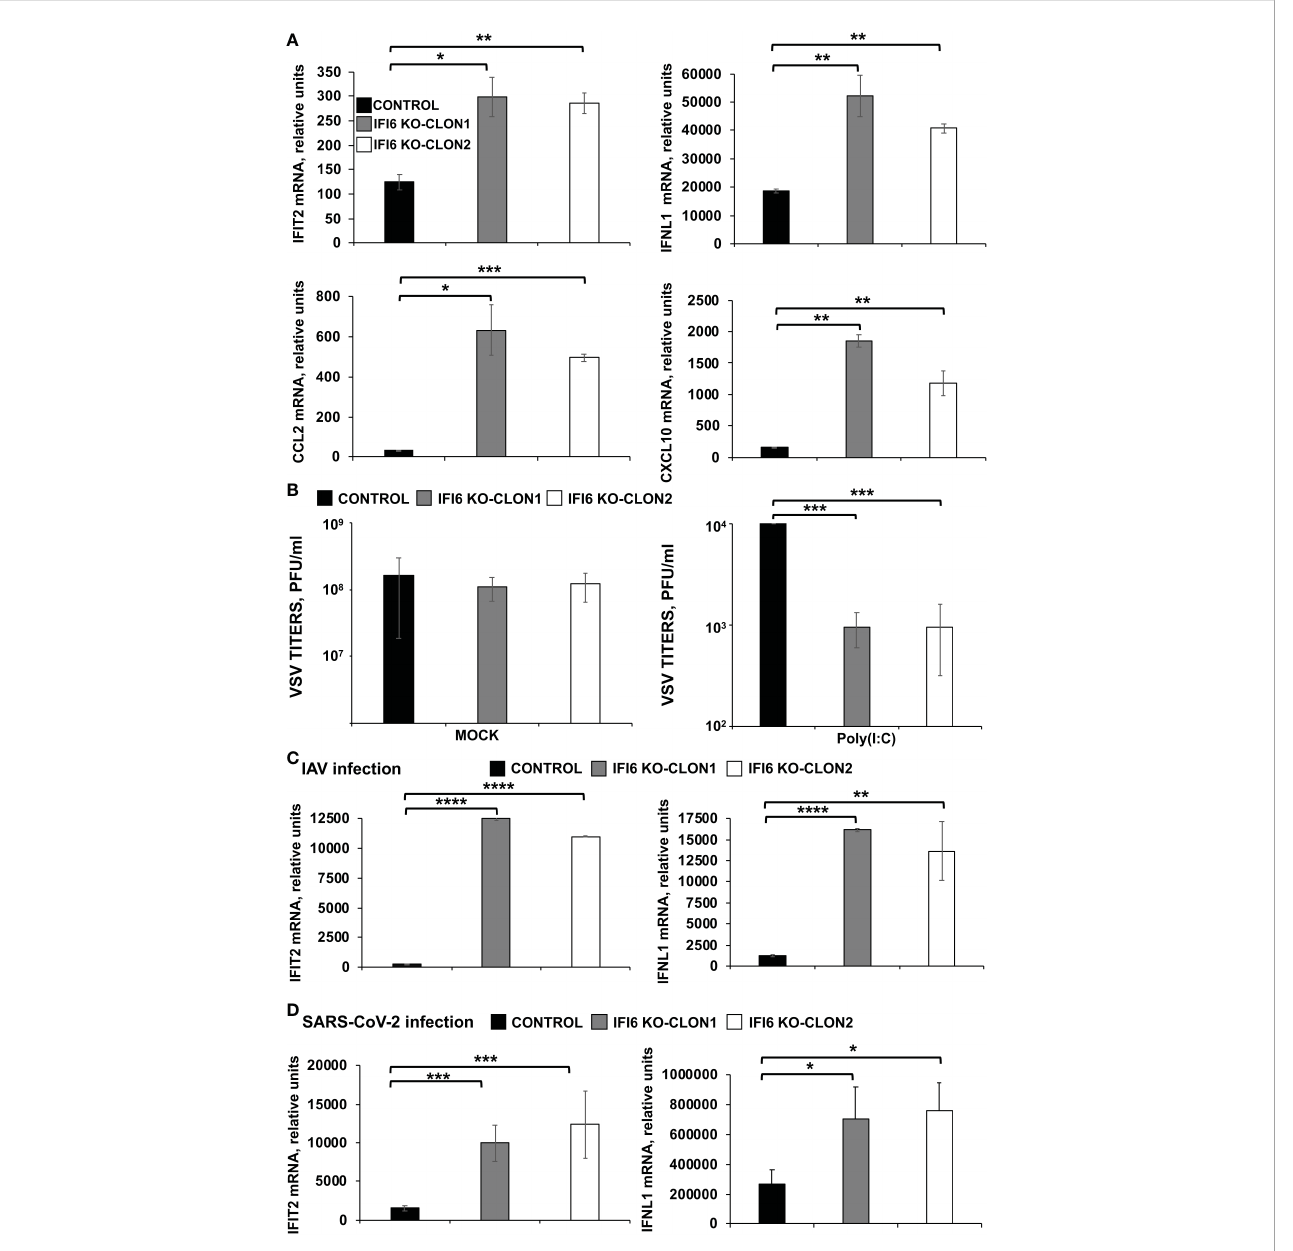
FIGURE 5 Effect of IFI6 on the modulation of innate immune responses induced by poly(I:C) and viral infections in A549 epithelial cells. (A, B) Two clones of A549 cells speci fi cally KO for the gene IFI6 were treated with poly(I:C). (A) To analyze the effect of IFI6 on innate immune responses, the levels of IFIT2, IFNL1, CCL2, and CXCL10 were evaluated by RT-qPCR at 24 hpt, and mRNA levels were expressed as fold change (increases) in comparison to mock-treated cells, used as controls. (B) Cells that had been subjected to mock treatment, or transfected with poly(I:C), were infected with rVSV-GFP (MOI of 0.1), and viral titers at 24 hpi were measured by a lysis plaque assay. Three different experiments were performed, with similar results. *P<0.05, **P<0.01, ***P<0.001 (using Student ’ s t test). (C) Two clones of A549 cells speci fi cally KO for the gene IFI6 were infected with IAV during 24 h. (D) Two clones of A549 cells speci fi cally KO for the gene IFI6 were infected with SARS-CoV-2 (MOI 1) during 48 h [59 – 62]. (C, D) The levels of IFIT2, and IFNL1 were evaluated by RT-qPCR at 24 hpt, and mRNA levels were expressed as fold change (increases) in comparison to mock-treated cells, used as controls. Three different experiments were performed, with similar results. *P<0.05, **P<0.01, ***P<0.001, ****P<0.0001 (using Student ’ s t